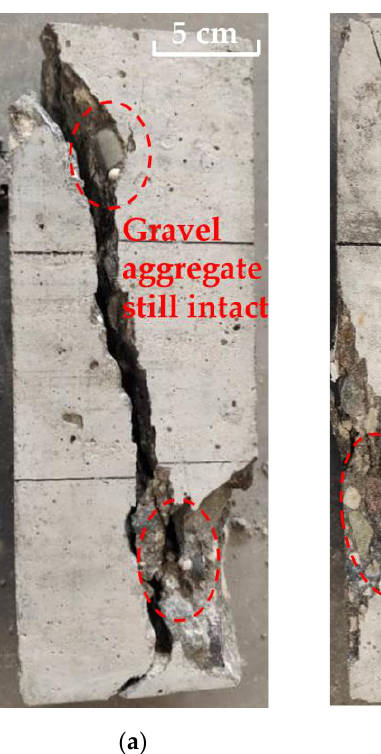
Figure 13. Failure mode of specimens: ( a ) gravel aggregate concrete specimen; ( b ) coral aggregate concrete specimen; ( c ) modified coral aggregate concrete specimen.